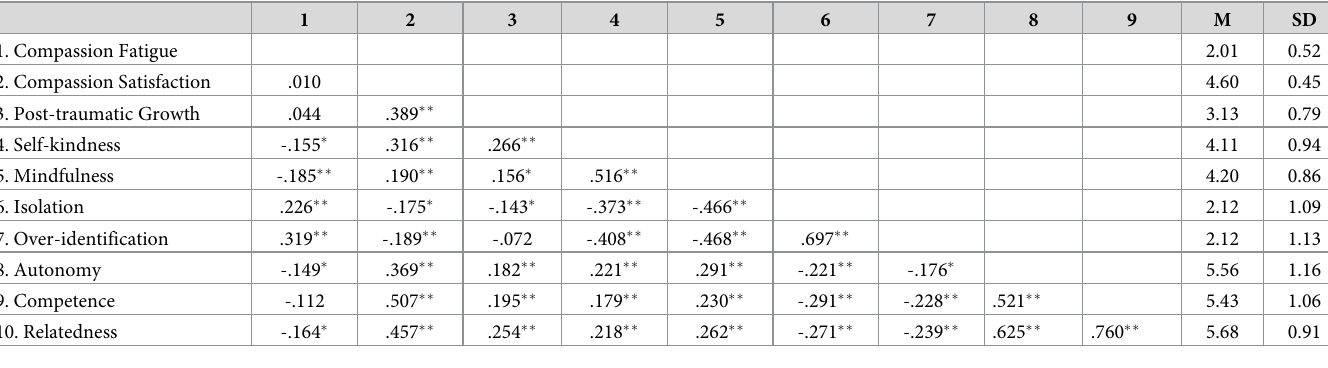
Table 1. Z-order correlations and descriptive statistics for the analyzed